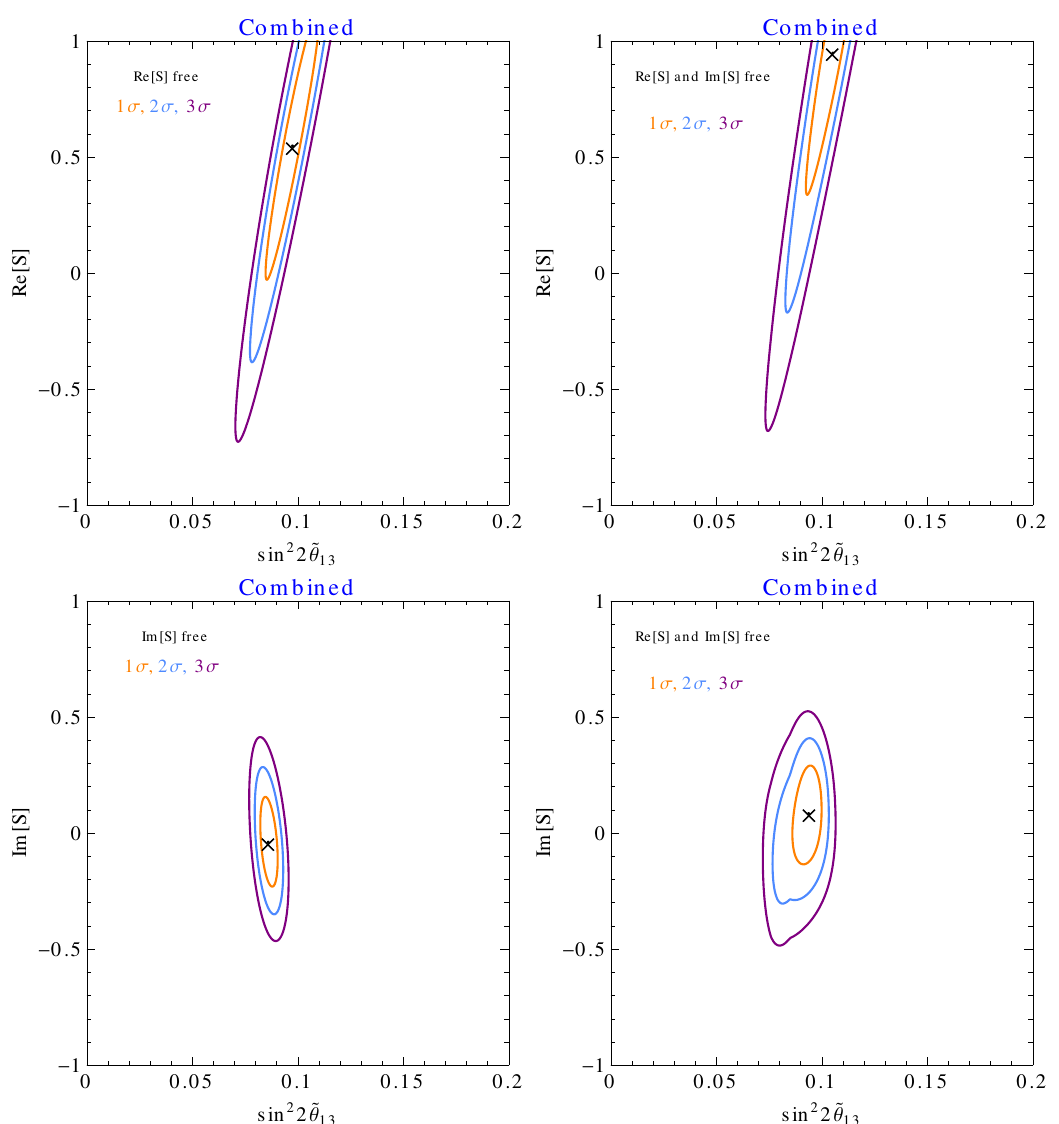
Figure 2 . Allowed regions in the (sin 2 2~ (cid:18) 13 (cid:0) Re [ S ]) ((cid:12)rst row) and (sin 2 2~ (cid:18) 13 (cid:0) Im [ S ]) plane (second row) for the combined data of the Daya Bay and RENO experiments. The 1-, 2-, and 3- (cid:27) regions are shown with orange, blue, and purple, respectively. In the left panels only Re [ S ] (or Im [ S ]) is varied at a time, while in the right panels both vary